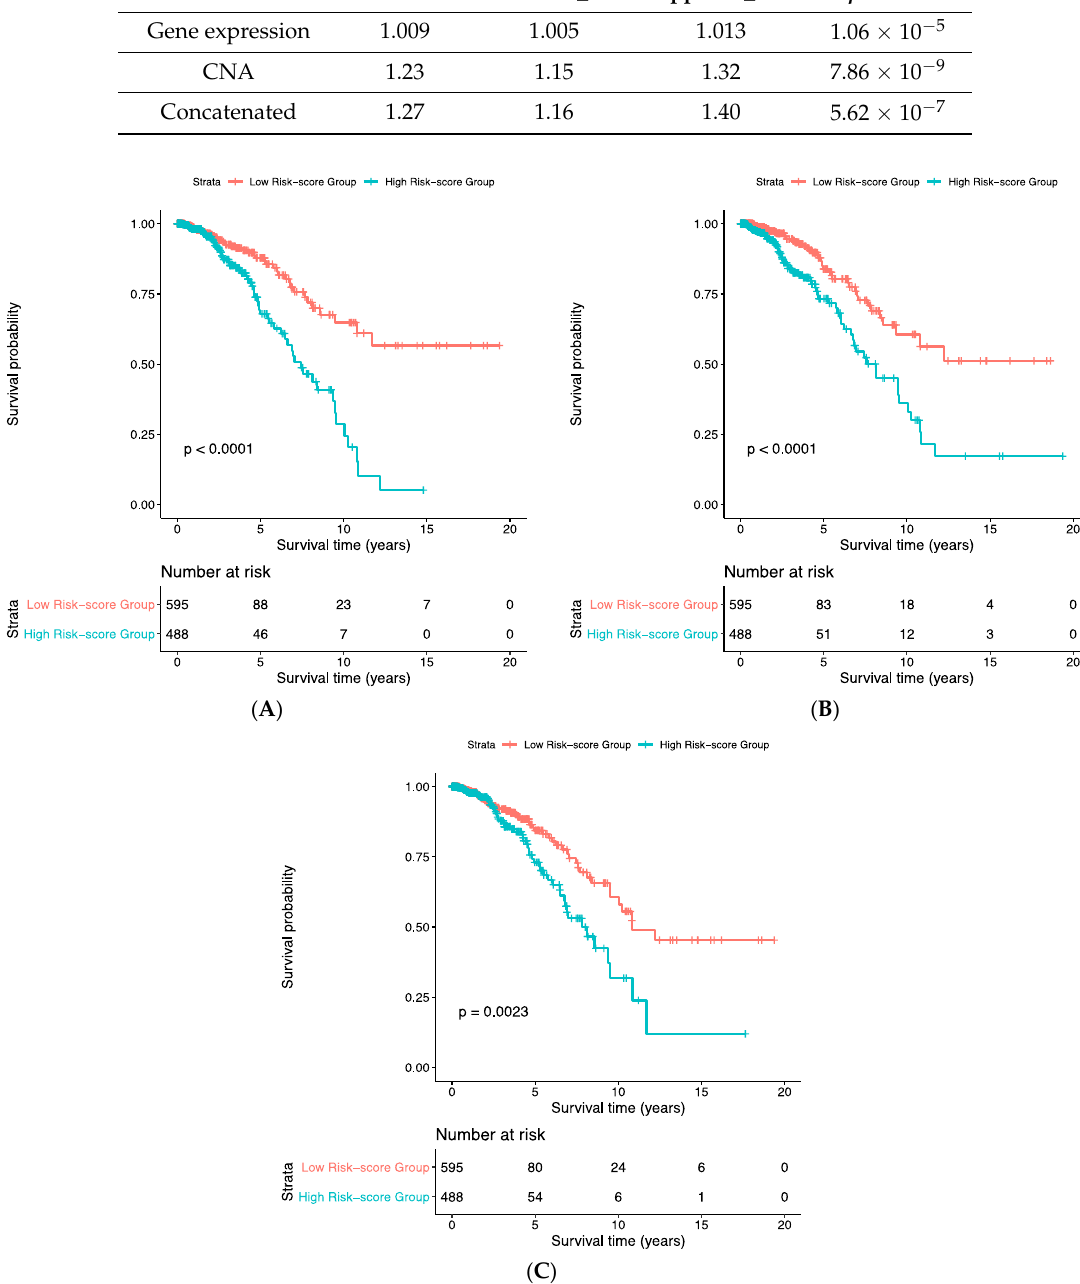
Table 4. The gene set enrichment analysis using Enricr.